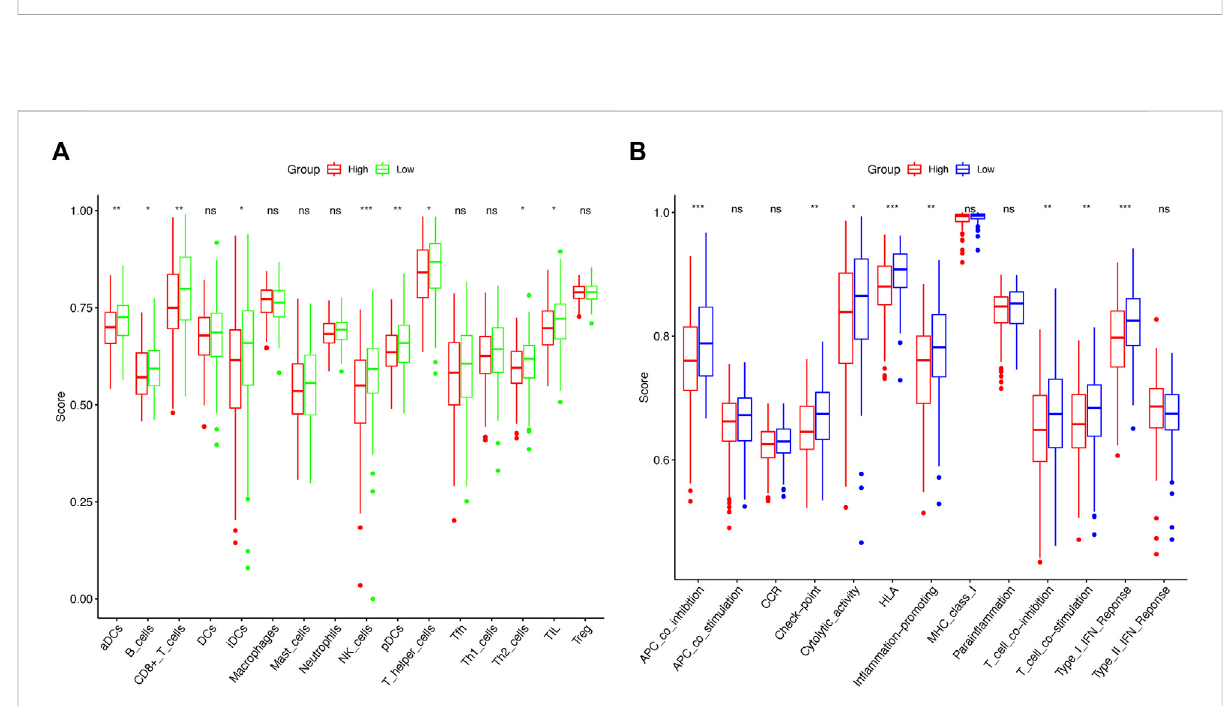
FIGURE 8 Functional annotation of the low-risk and high-risk groups in TCGA cohort. (A) Most signi fi cant GO enrichment. (B) Result of KEGG pathway enrichment based on the differentially expressed genes between the two risk groups (the longer bars indicate that more genes were enriched, and the deepening red indicates that the differences were more apparent).